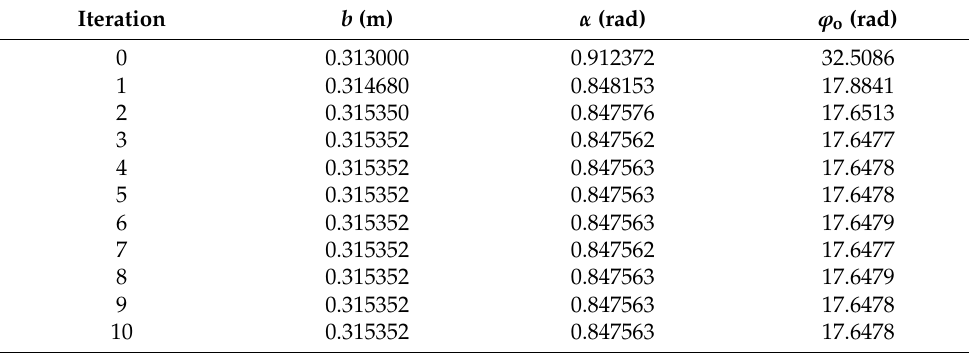
Table 2. Parameter calibration of the first scene of the Qionglai experiment in iterations.